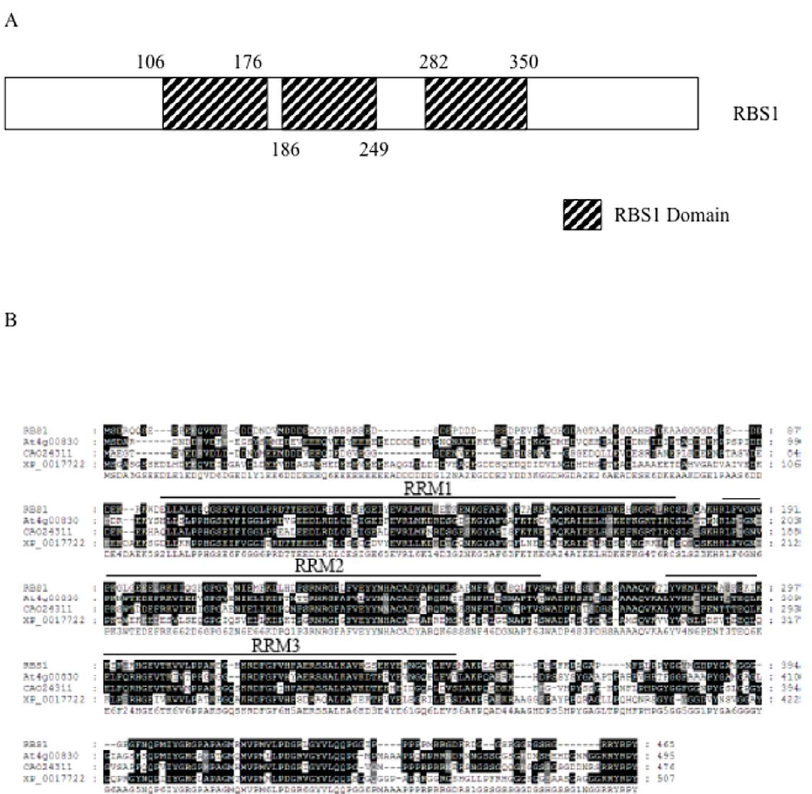
Figure 1. RBS1 is an RNA binding protein with three RNA Recognition Motifs (RRM). (A) Schematic representation of the RBS1 protein (B) Multiple sequence alignment of RBS1 and its putative plant orthologs. At4g00830, from Arabidopsis thaliana ; CAO24311 from grape ( Vitis vinifera ); XP_0017722 from the moss Physcomitrella patens subsp. patens . The alignment was performed with ClustalX and shading of amino acid residues with Genedoc.